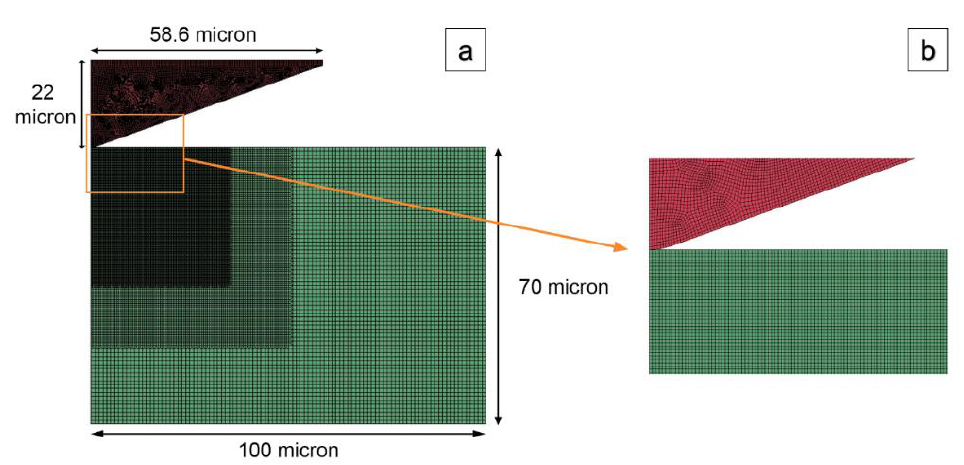
Figure 7. Axisymmetric models of the MMNC coating and indenter: ( a ) complete model; ( b ) zoomed view of the contact area.